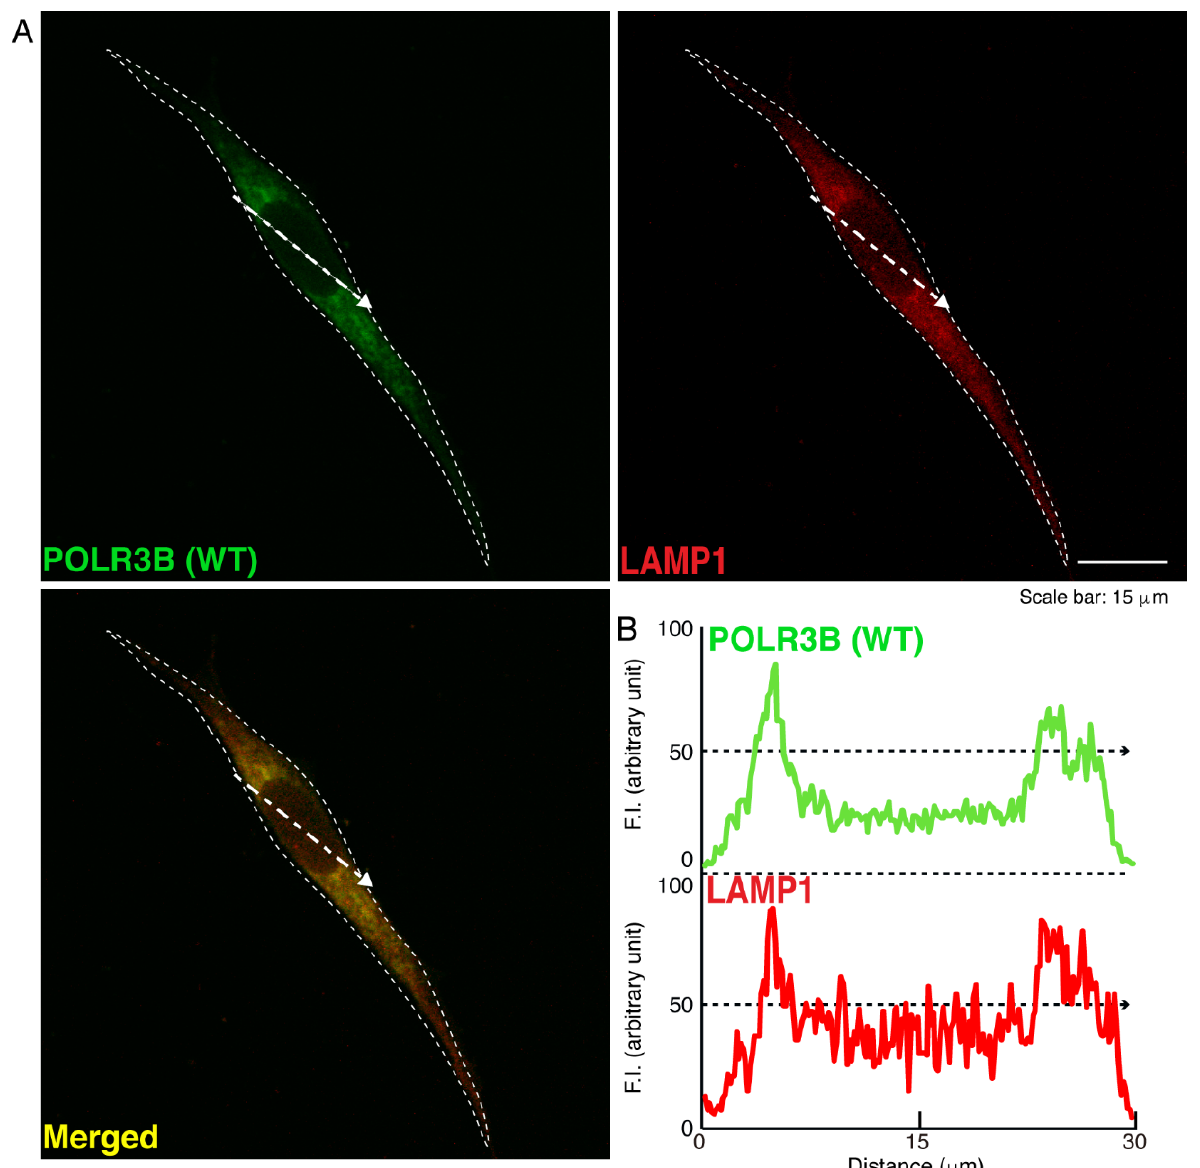
Figure 6. Wild type proteins are not significantly co-localized with the lysosome in cells. ( A , B ) Cells were transfected with the plasmid encoding the wild type (WT) POLR3B (green) and stained using an antibody against the LAMP1 antigen (red). Scan plots were performed along the white dotted lines in the direction of the arrows in the color images (green and red as well as merged images). Graphs showing the fluorescence intensities (arbitrary units) along the white dotted lines in the direction of the arrows (black dotted lines in right bottom panels) can be seen in the right bottom panels.